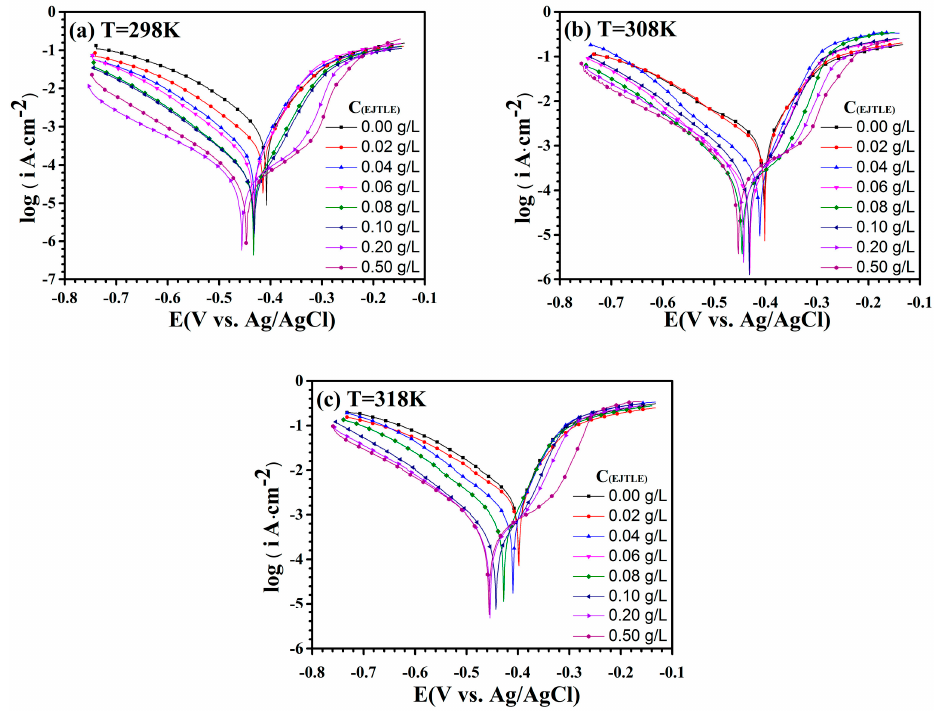
Figure 3. Polarization curves of C-steel in 1 M HCl solution with different concentrations of EJTLE at ( a ) 298 K; ( b ) 308 K; and ( c ) 318 K.